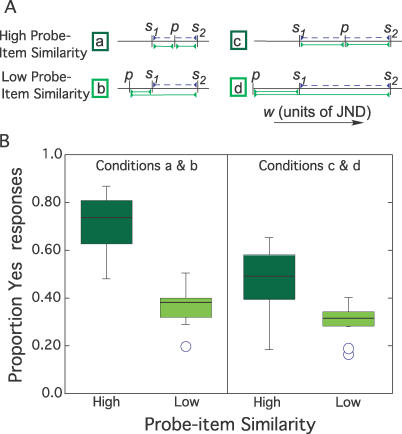
Effect of Probe-Item Similarity(A) A schematic diagram of four stimulus conditions. These examine effects of summed probe-item similarity on participants' report of having seen a stimulus. Conditions a–d keep inter-item homogeneity constant (pairs a & b and c & d) while changing summed probe-item similarity. These diagrams show the relationships between conditions, rather than the actual values stimuli may take. Throughout, summed probe-item similarity is denoted in green, whereas inter-item similarity is denoted in blue. Conditions in the first row have high summed similarity (indicated by the shorter green solid bars). These are identical to their pairs (b and d, respectively) in the second row in terms of inter-item homogeneity (indicated by the length of the blue dashed bar), and similarity of the probe to the closest item (shorter of the two green solid bars). The second row shows cases of lower summed similarity (longer green solid bars).(B) The results of the experiment. For each pair of otherwise matched stimuli, when summed similarity is larger, participants are more likely to indicate that a probe has been seen before (p < 0.01). These box plots show the median (thick bar), and boxes include the middle 50% of data. The whiskers include all data points that are not outliers. Outliers are shown as circles, and defined as those points more than 1.5 times the interquartile range from the median. Light and dark green indicate high (conditions a & c) and low (conditions b & d) summed similarity, respectively.